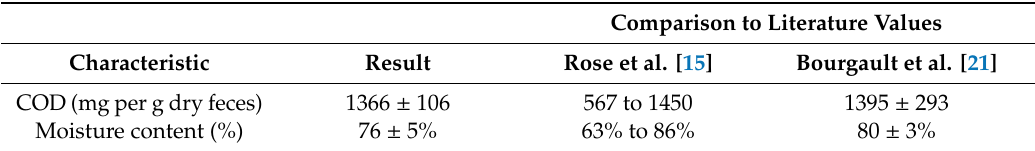
Table 2. Comparison of results from characterization of fresh feces samples (n = 7) with literature values. When available, values given as averages ± standard deviation.